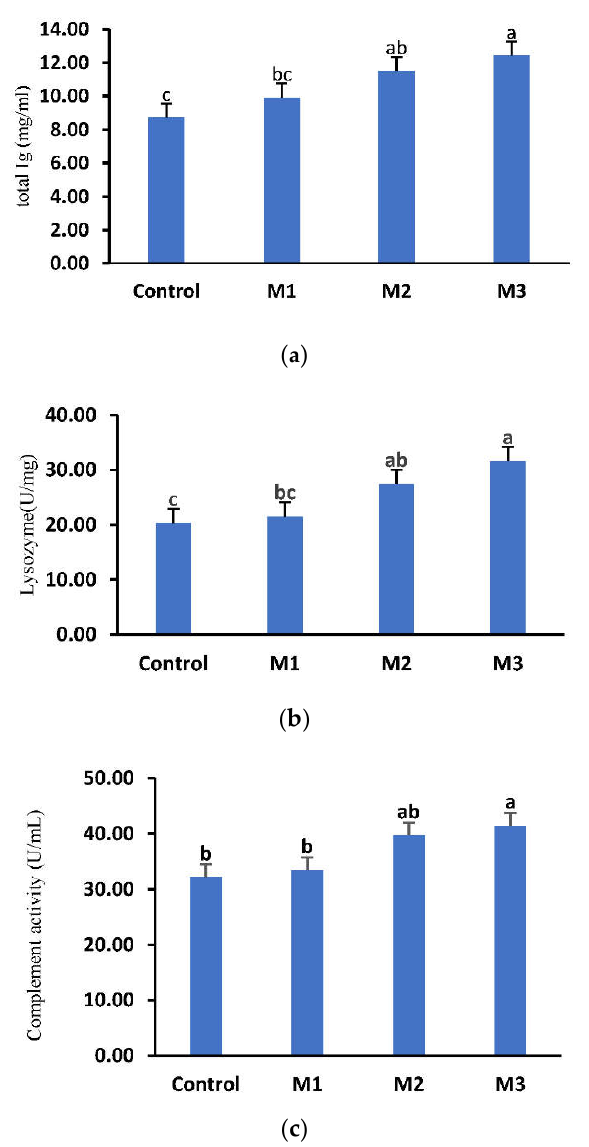
Figure 1. Serum immunological responses (total Ig ( a ), Lysozyme ( b ), and complement activity ( c )) of C. carpio fed incorporated diet with zero (control), 0.5% (M1), 1% (M2), and 2% (M3) of Myristica fragrans for four weeks. Values are presented as the mean ± SE. Different letters indicate significant difference ( p < 0.05).